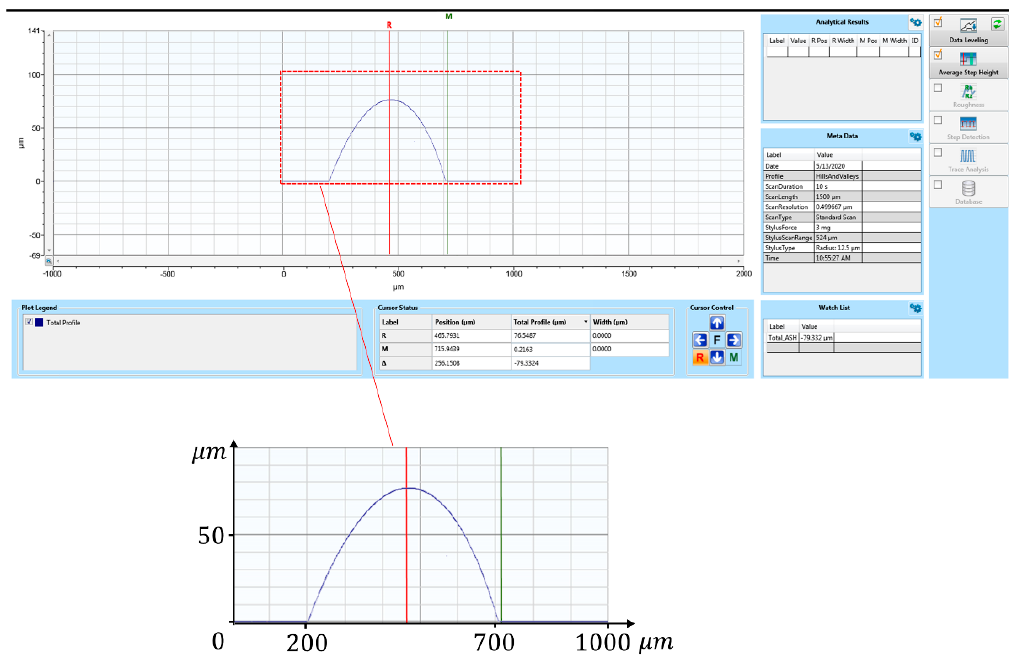
Figure 7. The outline of the sample measured by stylus profiler.